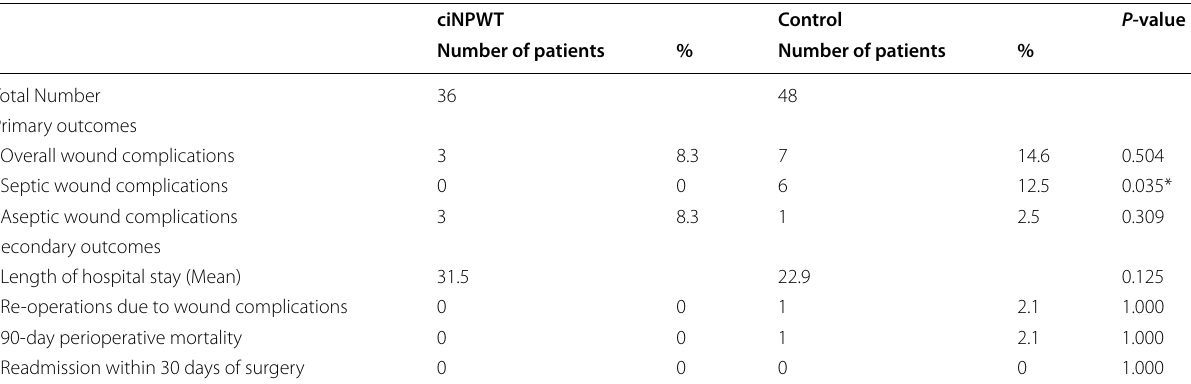
Table 4 Summary of primary and secondary outcomes